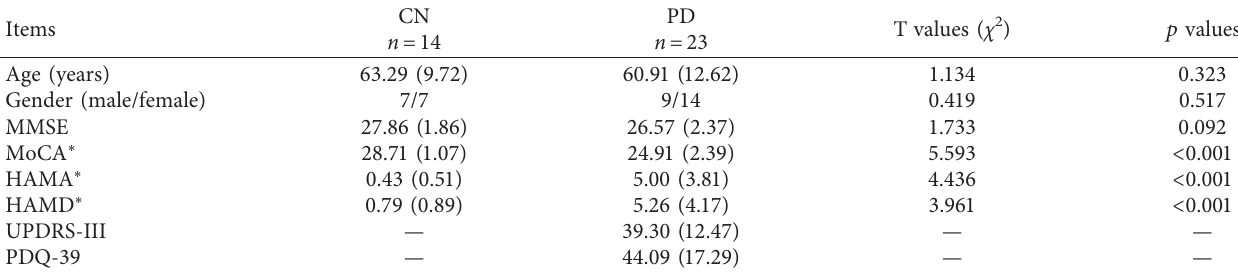
Table 1: Demographics and clinical measures of patients with PD and controls.